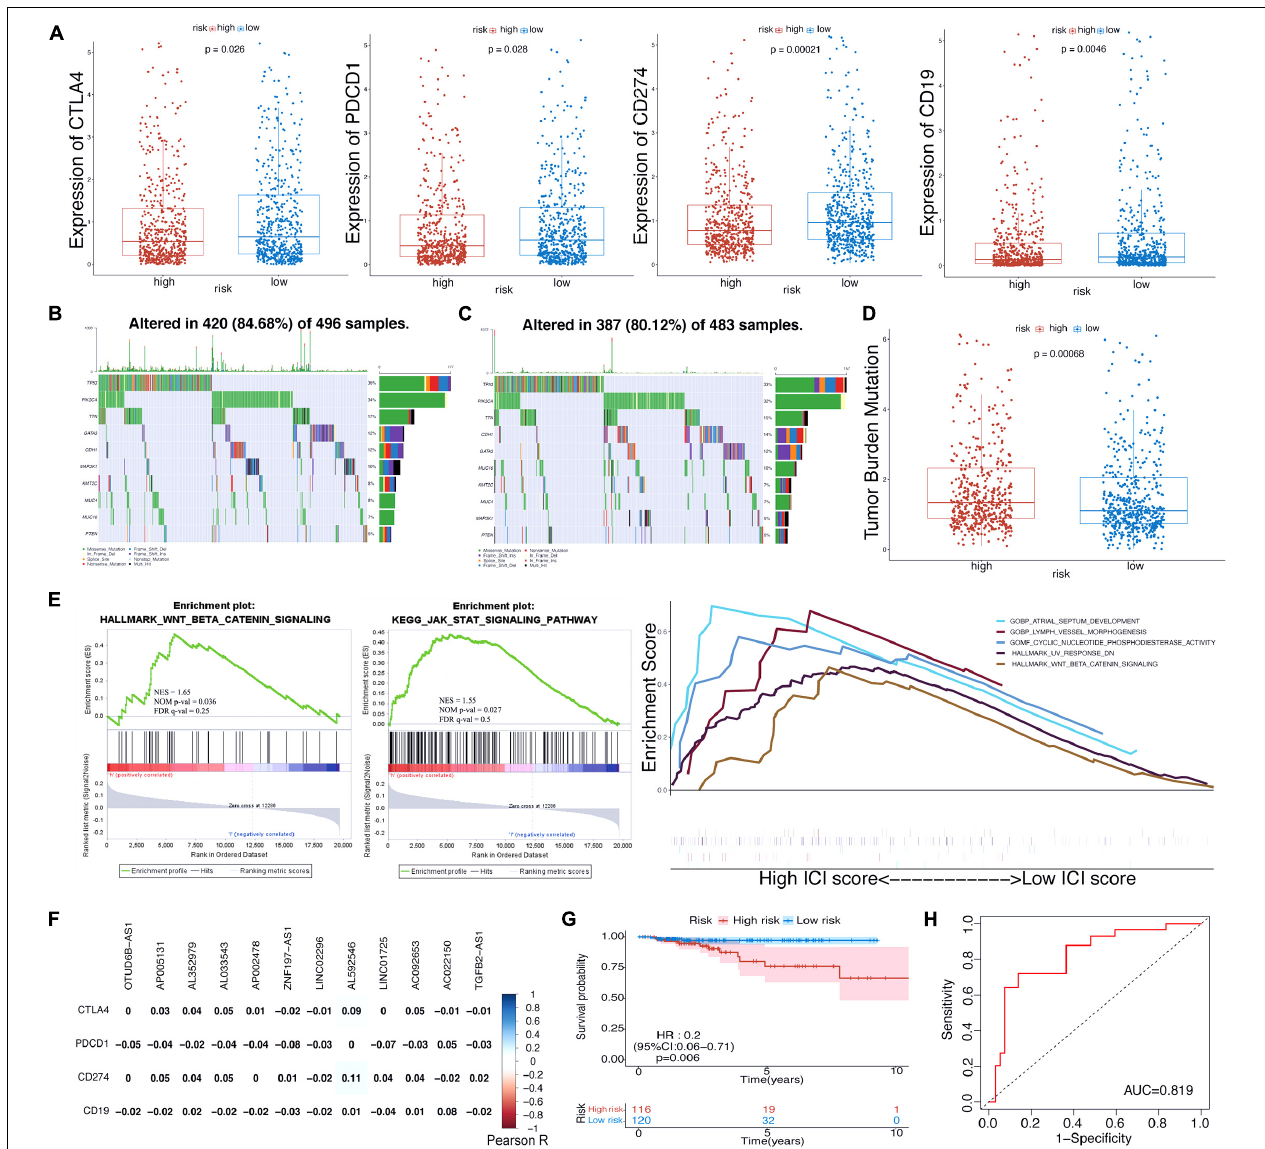
FIGURE 3 | (A) The expression level of CTLA4, PDCD1, CD274, and CD19 in high-/low-risk subtypes in TCGA cohort. (B,C) Waterfall maps of eight mutated genes in high-/low-risk subtypes. (D) The difference of tumor mutational burden between the high- and low-risk subtypes. (E) Gene set enrichment analysis (GSEA) showed the tumor hallmarks enriched in the high-risk subgroup and the relevance between biological process, molecular function, and hallmarks and m 6 A-LPS. (F) Heatmap of the correlations between four immune targets and the 12 prognostic m 6 A-related lncRNAs. (G) Kaplan–Meier curves of OS for BRCA patients in